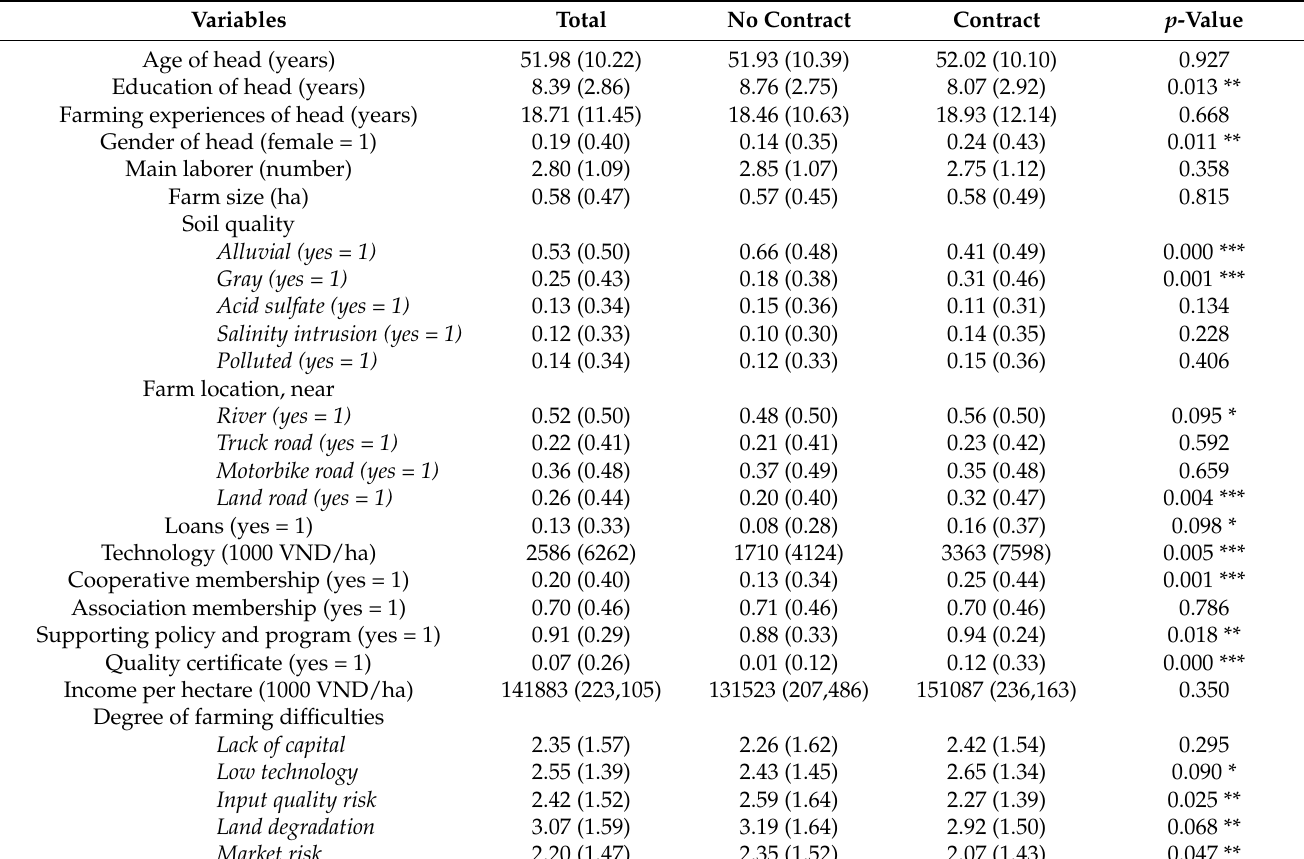
Table 2. Descriptive statistics of outcome and explanatory variables in the